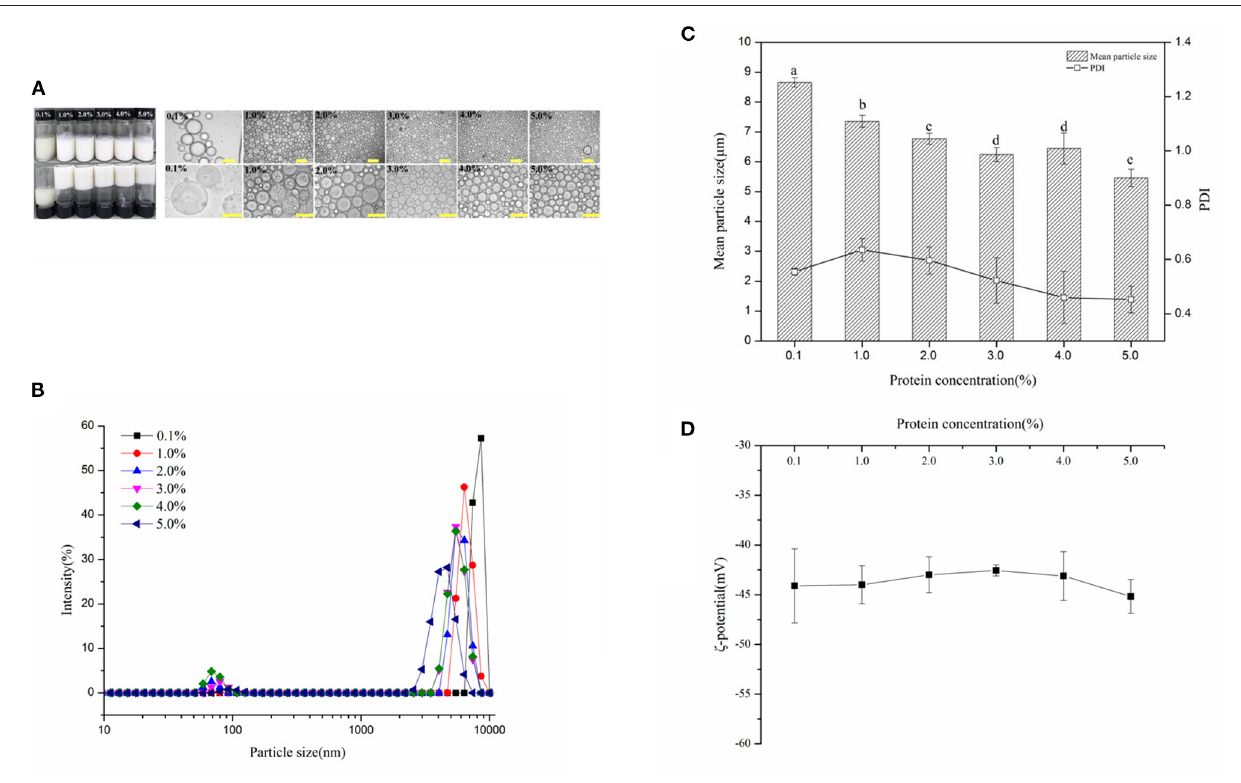
75%), at varying protein concentration c values of 0.1–5 wt%.